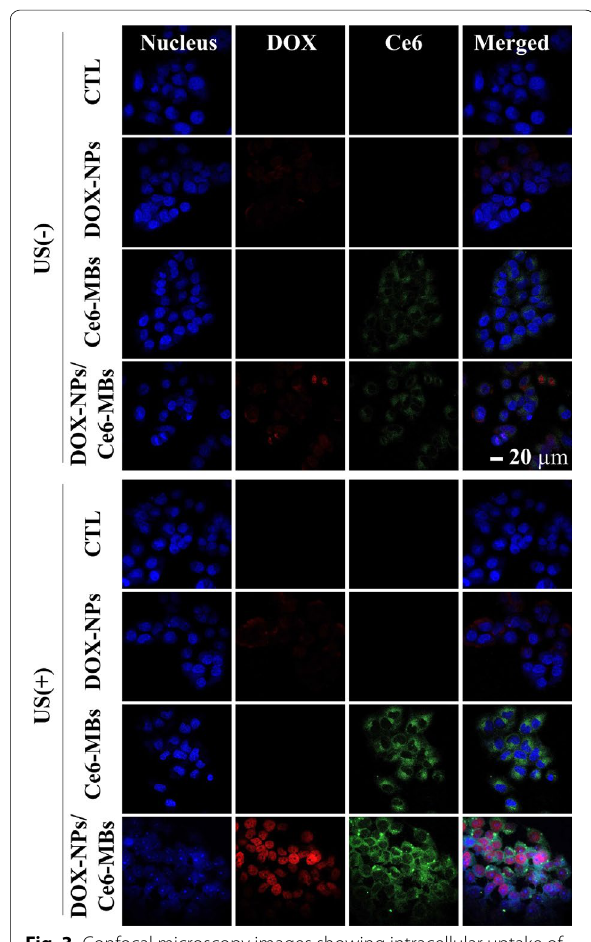
Fig. 3 Confocal microscopy images showing intracellular uptake of DOX and Ce6 in MCF-7/ADR cells with or without US irradiation. The blue color represents cell nuclei. Red and green channels represent DOX and Ce6, respectively (scale bar 20 =